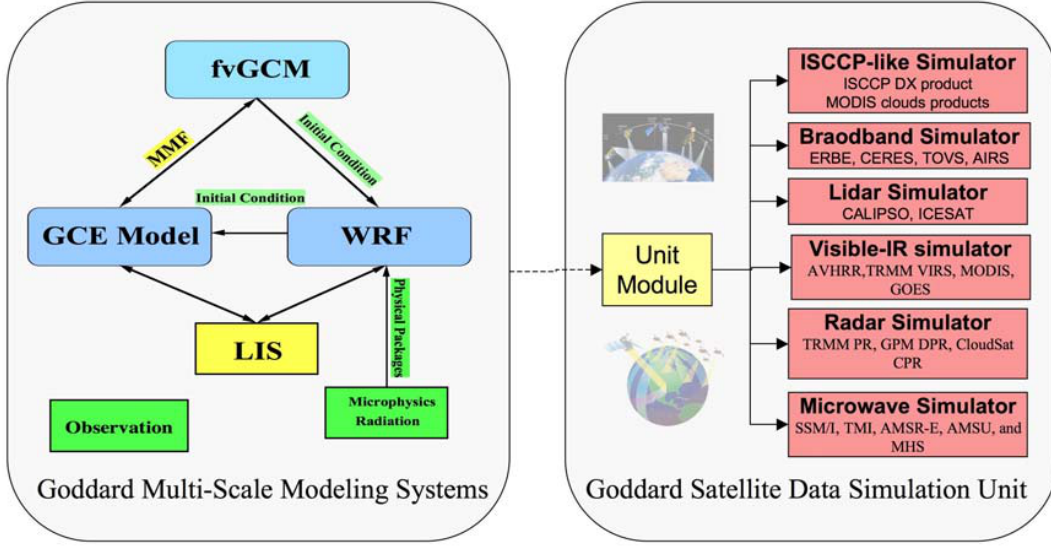
Fig. 2. Schematic diagram of the Goddard Multi-scale Modeling System with unified physics coupled with the Goddard Satellite Data Simulation Unit (SDSU). The coupling between the fvGCM and GCE is two-way [termed a multi-scale modeling framework (MMF)], while the coupling between the fvGCM and WRF and WRF and the GCE is only one-way. LIS is the Land Information System developed in the Goddard Hydrological Sciences Branch. LIS has been coupled interactively with both WRF and the GCE. Additionally, WRF has been enhanced by the addition of several of the GCE model’s physical packages (i.e., microphysical scheme with four different options and short and long-wave radiative transfer processes with explicit cloud-radiation interactive processes). Observations (obtained from satellite and ground-based campaigns) play a very important role in providing data sets for model initialization and validation and consequently improvements. The Goddard SDSU can convert the simulated cloud and atmospheric quantities into radiance and backscattering signals consistent with those observed from NASA EOS